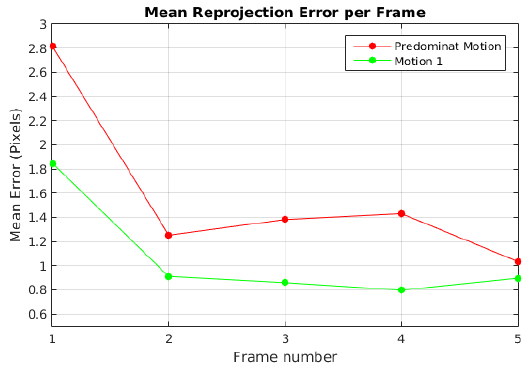
Figure 3. Mean reprojection error by frame for Scene